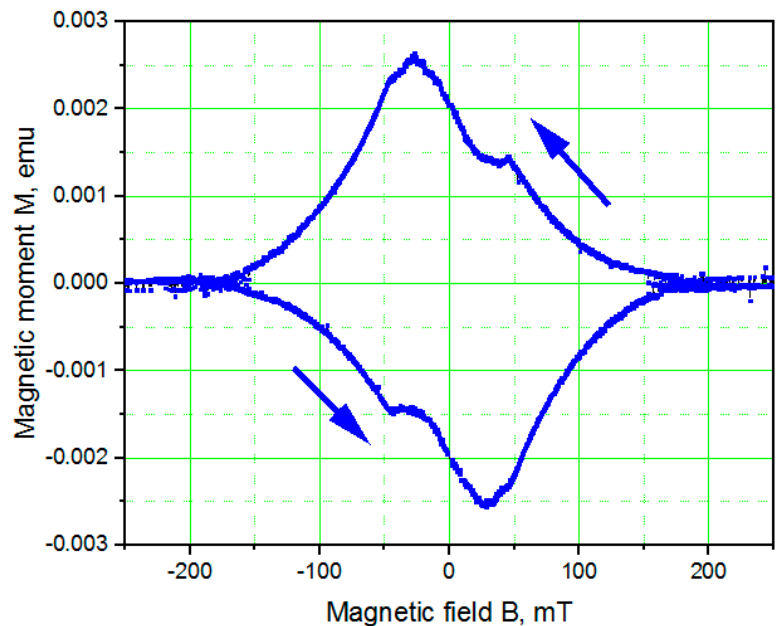
Figure 5. Dependence of magnetic moment M ( B ) of a 1.2- µ m-thick TiN film deposited on a Si substrate with a 20-nm-thick SiN buffer layer recorded at 1.9 K. The magnetic field was applied parallel to the surface of the film.